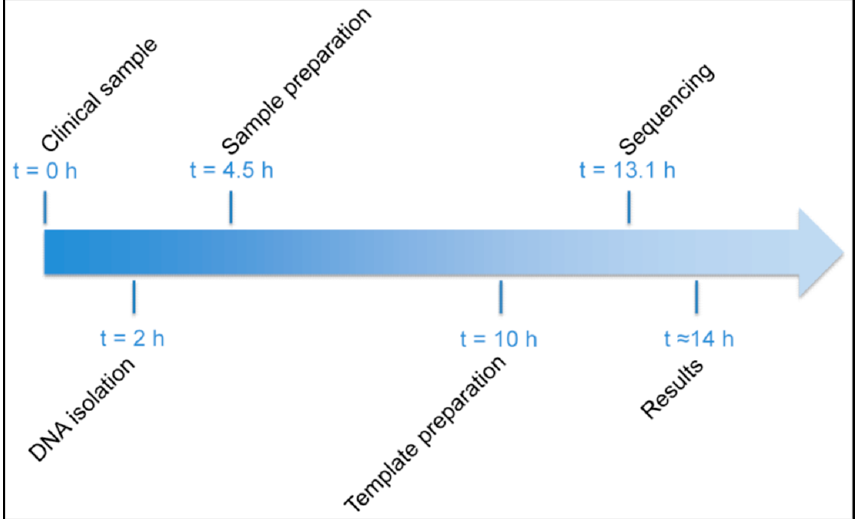
Figure 1. Accelerated workflow for the amplicon-based next-generation sequencing method used in the present study.